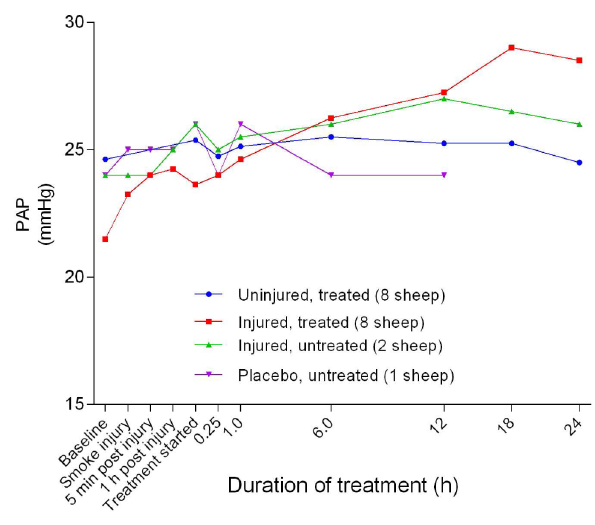
Figure 24. Pulmonary artery pressure (PAP) (Mean ± SD, no error bars shown) in smoke and non-smoke injured sheep that received extracorporeal life support as compared to that in untreated